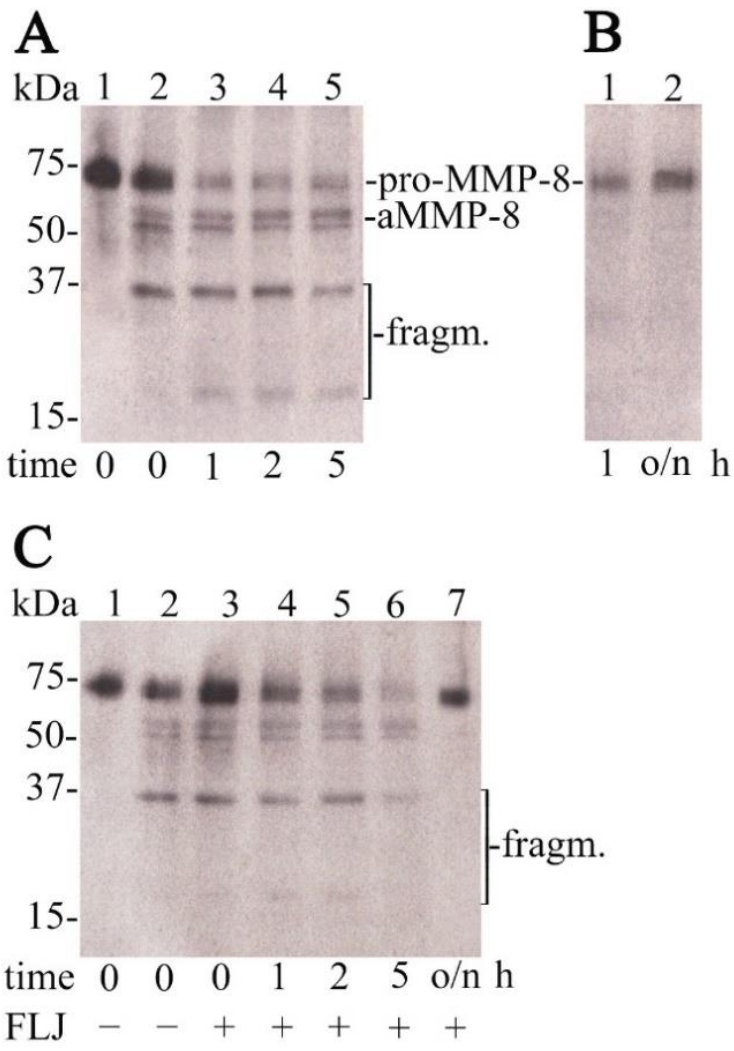
Figure 2. Candida glabrata T-1639 cell wall proteolytic fraction induced proMMP-8 activation, and inhibition of activation by fermented lingonberry juice (FLJ). ( A ). 1. proMMP-8 control, 2.–5. Candida